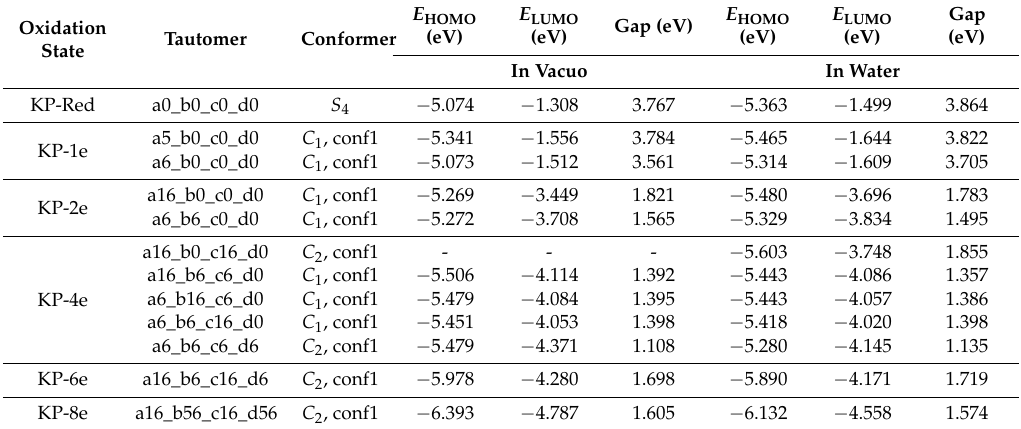
Table 17. HOMO and LUMO energies, and corresponding HOMO–LUMO gaps, computed at the PBE0/6-311++G(2d,2p)//BE0/6-31+G(d,p) level in vacuo and in water.